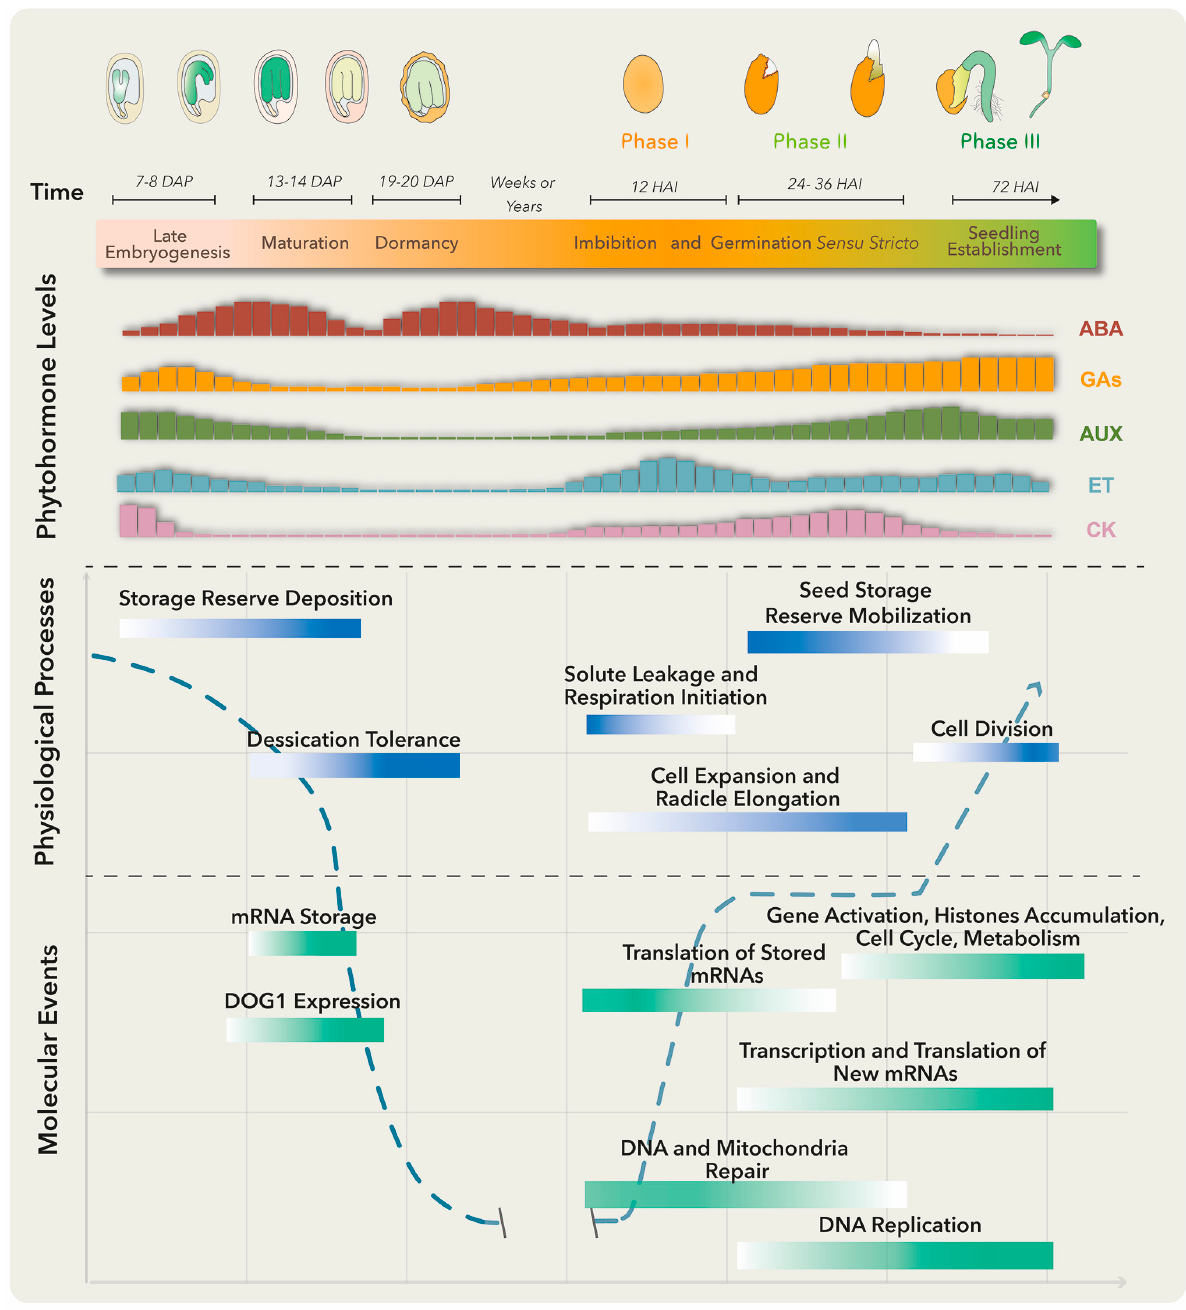
Figure 1. Molecular, biochemical and physiological processes occur from embryo maturation through dormancy to impact on seed germination. The upper panel represents the late seed developmental stages of a dicotiledoneous plant on the left and germination to seedling establishment stages on the right. The lower panels include, from top to bottom, changes in specific phytohormone levels; and physiological processes and molecular events that particularly represent the maturation, dormancy and germination stages. Longer bars refer to higher levels. Abscisic acid (ABA) positively regulates embryo maturation, dormancy induction and maintenance, while gibberellins (GAs) promote release from seed dormancy and germination. Ethylene (ET) production rises after seed soaking with a peak before radicle protrusion. The dashed blue line represents the water level throughout different developmental stages. DAP means days after pollination, and HAI means hours after imbibition.